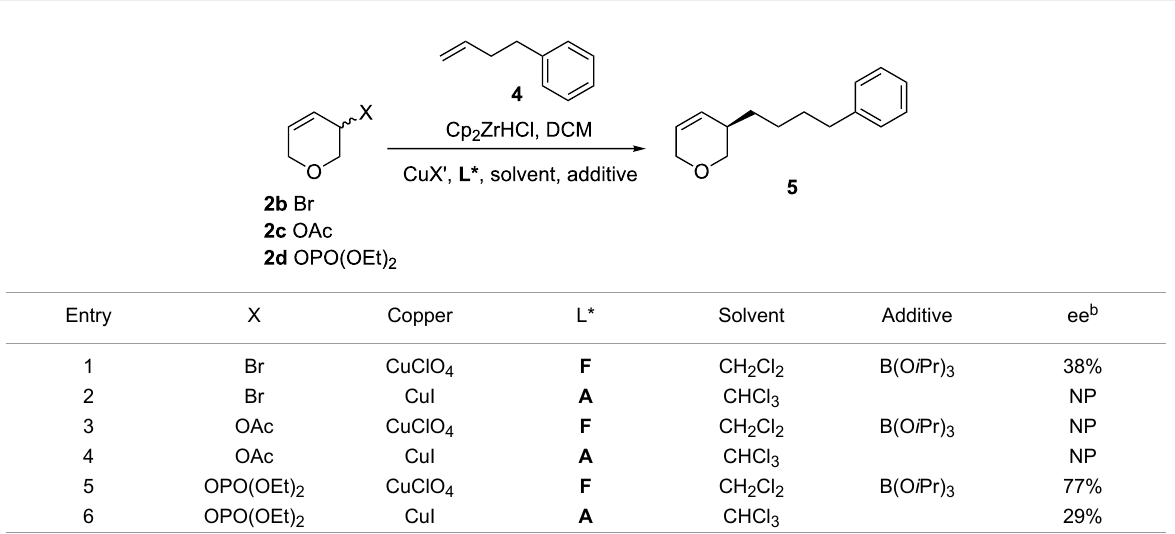
Table 2: Effect of leaving groups.